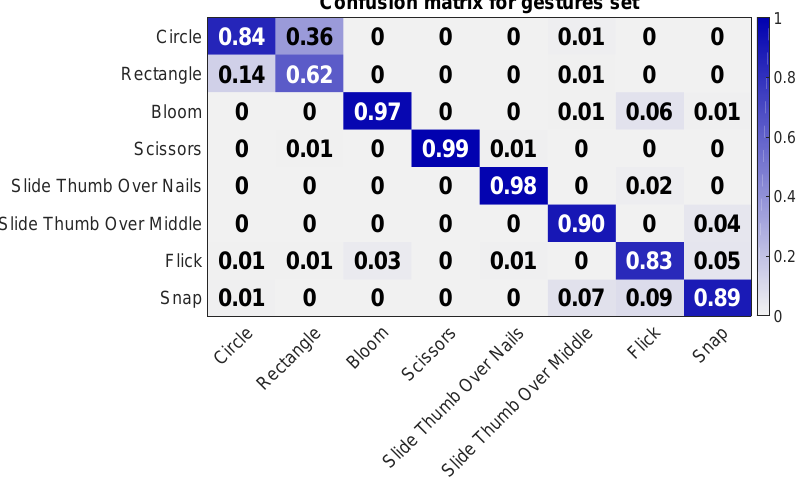
Figure 12. Confusion matrix for the finger gesture set using only capacitive measurements. The columns refer to the actual class, and the rows to the assigned ones during the classification.